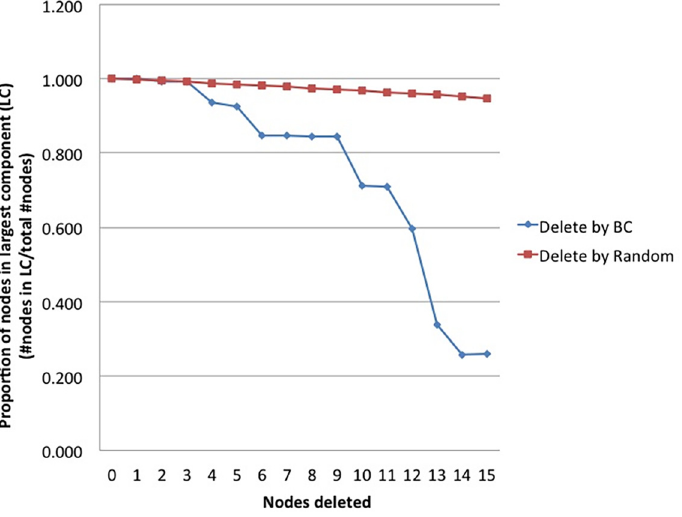
doi:10.1371/journal.pone.0151174.g006